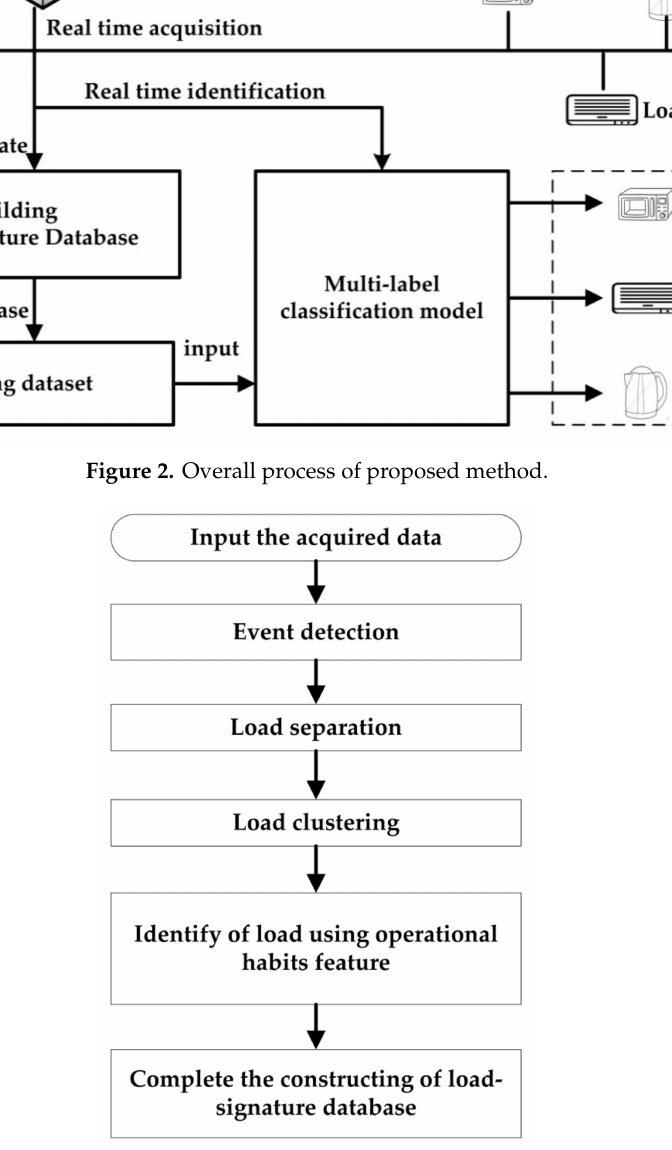
Figure 3. The process of building load-signature